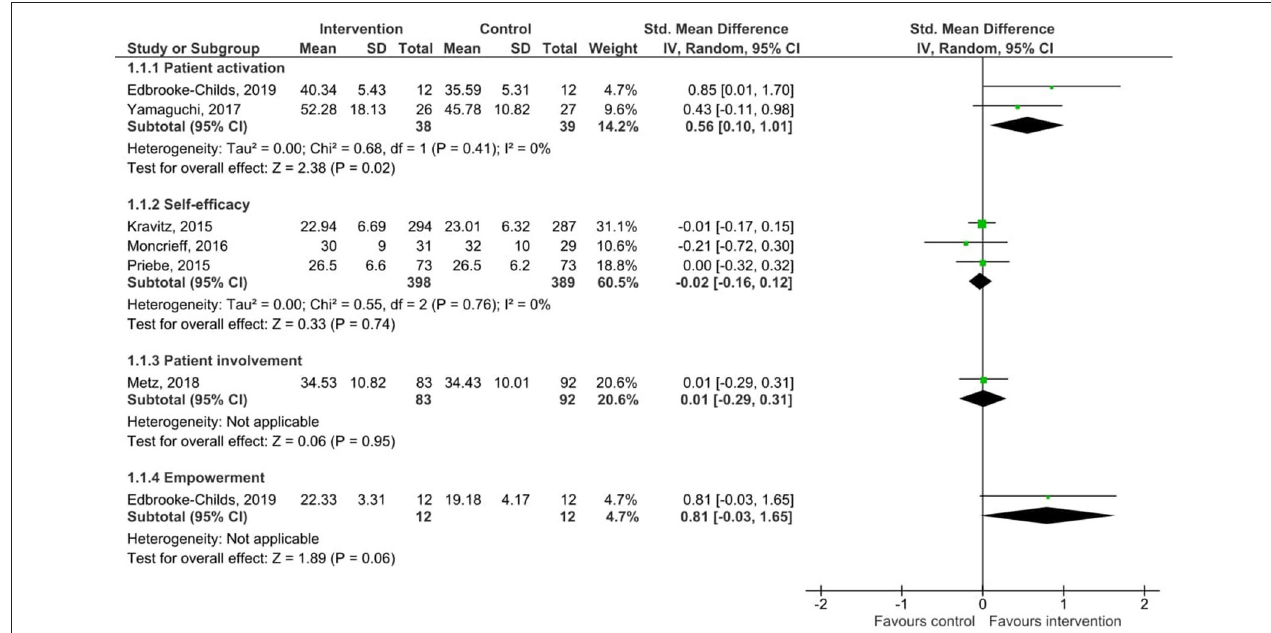
FIGURE 3 | Forest plot for patient activation and indices of the